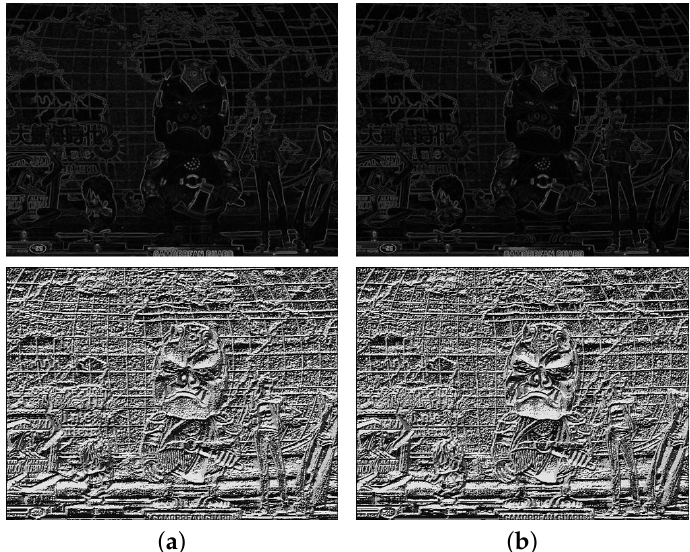
Figure 6. The gradient magnitude and LBP images of channels shown in Figure 3: gradient magnitude ( top ); LBP ( bottom ) of ( a ) red and ( b ) green